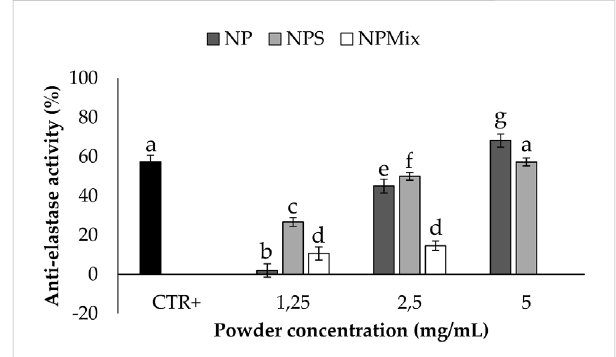
FIGURE 6 Results of the anti-elastase activity of the samples. The positive control is epigallocatechin gallate tested at a 7.2 mg/mL concentration in deionized water. Data are reported as mean value ± LSD, Multifactor ANOVA, n = 3. Letters (a, b, c, d, e, f and g) are used to compare the means of different groups. If the letters are different, there is a statistically signi fi cant difference between the means ( p < 0.001); if the letters are the same, there is no statistically signi fi cant difference between the means ( p > 0.05).